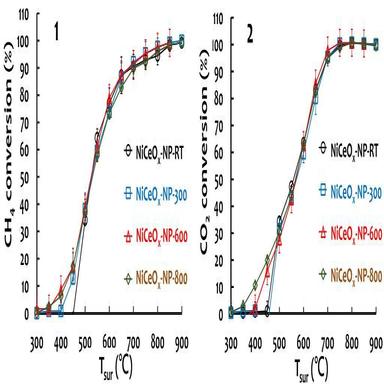
DRM catalyzed by the NiCeOx-NP samples with different Td2. 1: XCH4 versus Tsur; 2: XCO2 versus Tsur. Reprinted with permission from Ref..